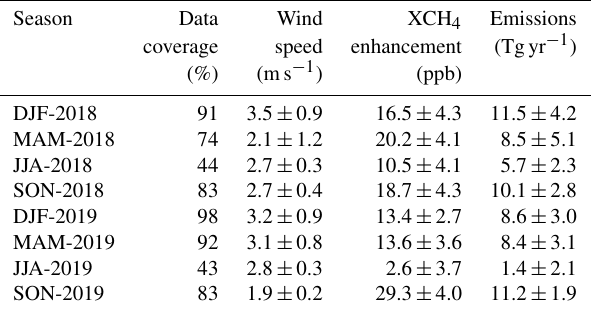
Table 1. SSWR XCH 4 enhancement and emission estimates. The enhancements ( (cid:49) XCH 4 ) are the XCH 4 difference between SSWR and the background after correcting XCH 4 for latitudinal variations. Data coverage is defined here as the fraction of 0.1 ◦ × 0.1 ◦ grid cells in SSWR with at least five high-quality TROPOMI measure- ment in a quarter. Wind speed is the average boundary layer wind from ERA5. Emission estimates are calculated using Eq. (1); ± rep- resents 1 σ